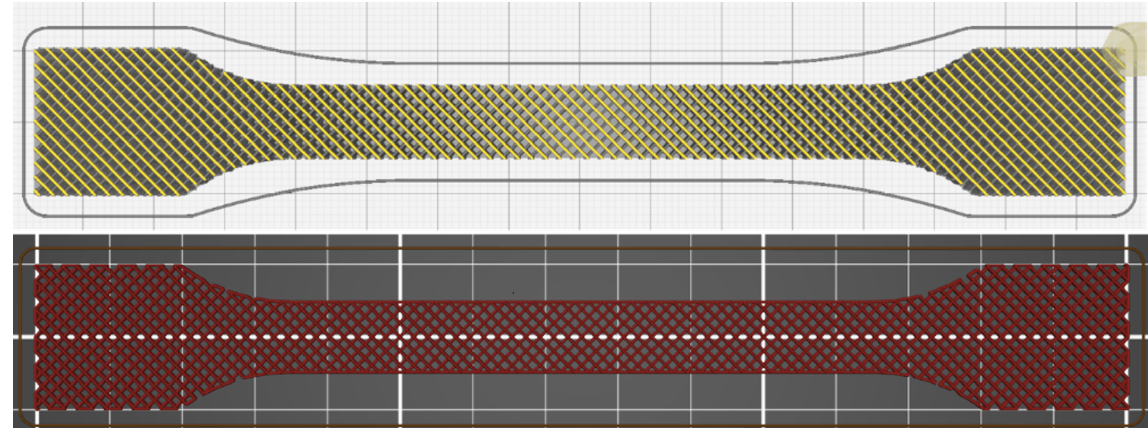
Figure 7. Visualizations of the structures generated in Cura ( top ) and PrusaSlicer ( bottom ). Based on Equation (6), the fiber fill factor was determined. An adequate box plot is shown in Figure 8. In the case of PrusaSlicer, the factor depends on the layer height. The identified values of the parameter percentage volumetric fill are presented in Table 2.